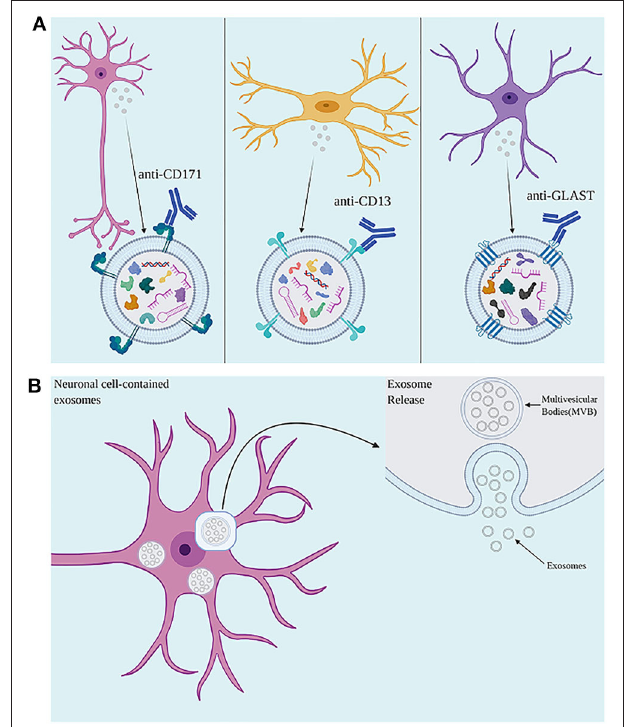
FIGURE 2 | (A) Use of antibodies against cell surface proteins present on exosomes allows for isolation of neuronal-, microglial-, and astrocyte-derived exosomes. (B) The accumulation of intraluminal vesicles (ILVs), exosome precursors, forms Multivesicular bodies (MVBs). MVBs fuse with the plasma membrane, releasing exosomes to the extracellular environment. Created with